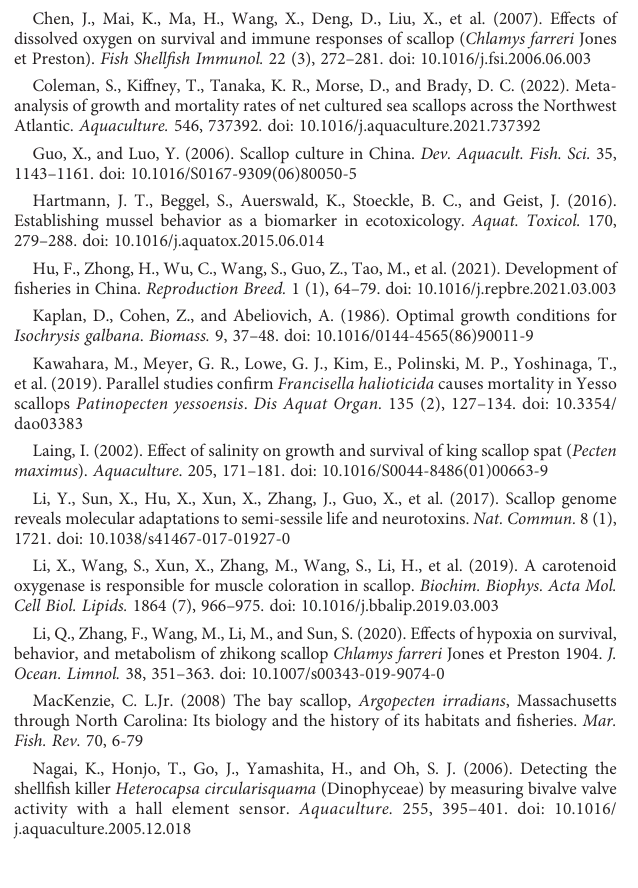
SUPPLEMENTARY FIGURE 1 Dimensional distribution of scallop.